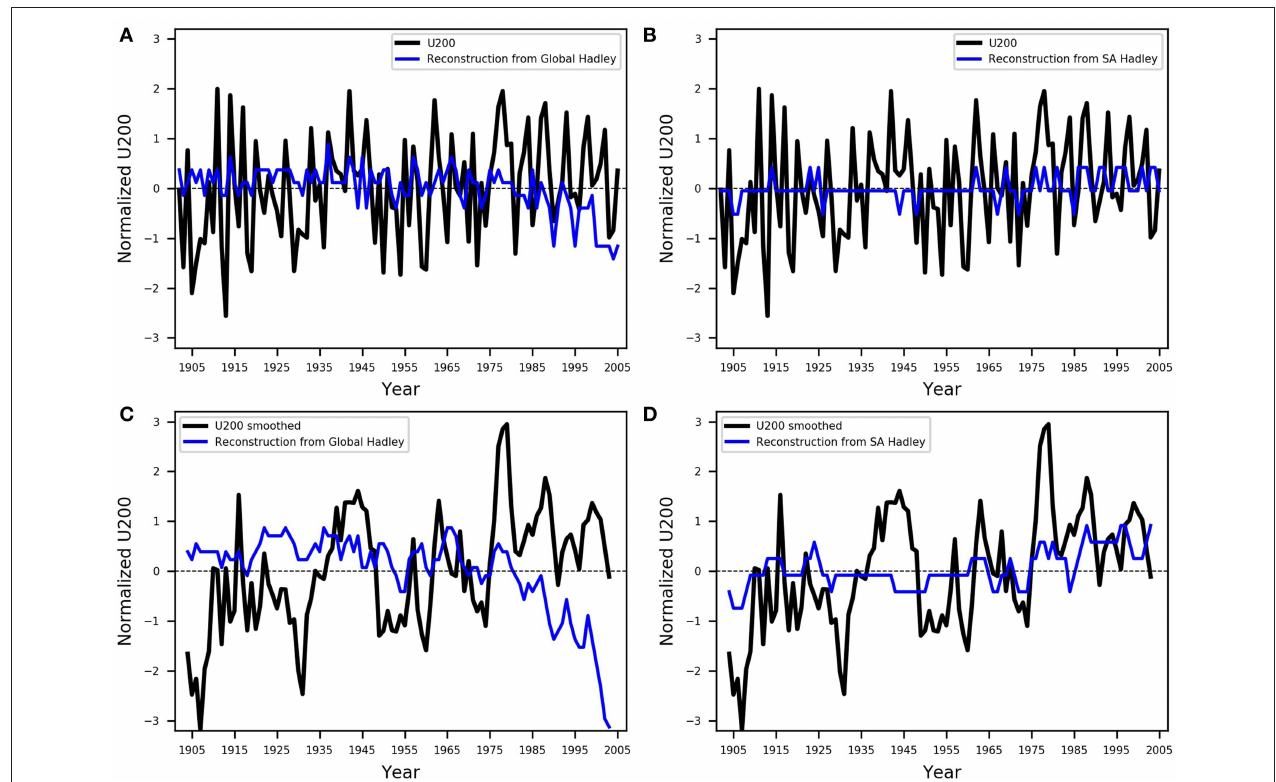
FIGURE 8 | Normalized U200 anomaly time series in the Altiplano (black) and those reconstructed by linear regressions(blue)based on Hadley cell displacements computed either globally (A) or over South America only (B) . (C,D) same as (A,B) , but for smoothed series. Data were derived from CMIP5 Historical